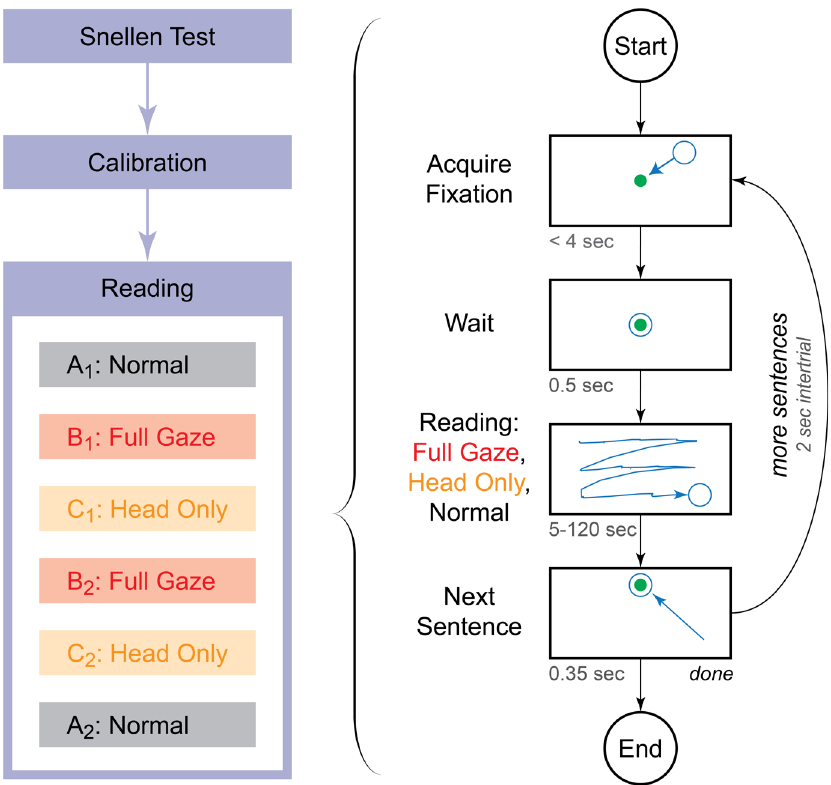
Figure 6. Overview of experimental design and procedure. (Left) Each subject’s session started with a coarse assessment of visual acuity using a traditional Snellen chart. This test was to verify that subjects had largely normal vision, rather than to precisely measure their visual acuity, as the experimental requirements were well below ordinary acuity. Then, after subjects were seated in front of the apparatus, a quick calibration of the gaze position system was performed, typically lasting 2–3 min. Finally, the experiment itself proceeded with the presentation of the six mini-blocks in sequence, starting with a control condition mini-block, followed by four experimental mini-blocks, and then closing with a second control mini-block. (Right) The reading task used a trial-based structure where each trial began with the subject fixating a central point using normal vision. After a brief pause, a simple, three-line sentence was presented on the screen in one of the three conditions, depending on the mini-block: the Normal condition using natural vision, and the Full Gaze and Head Only conditions using phosphene-view simulation to present the stimulus. In both phosphene view conditions, the phosphenes were stabilized on the retina; in the Full Gaze condition, the simulated scene camera was steered by the combination of eye and head positions, whereas in the Head Only condition, the scene camera was steered only by head position. For all three conditions, the subjects read the sentence aloud as best they could, and then fixated the Next Sentence dot to proceed to the next